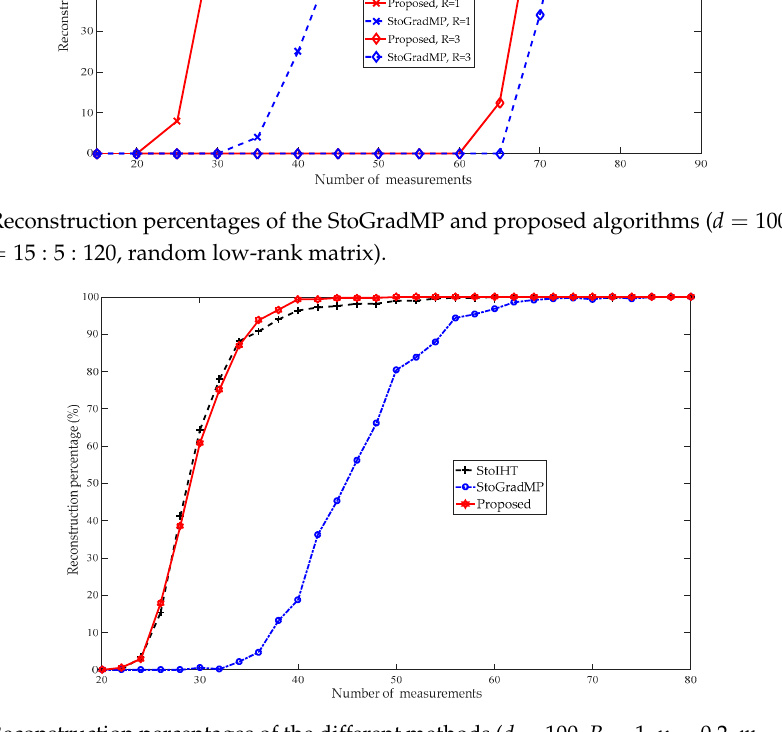
Figure 13. Reconstruction percentages of the different methods (